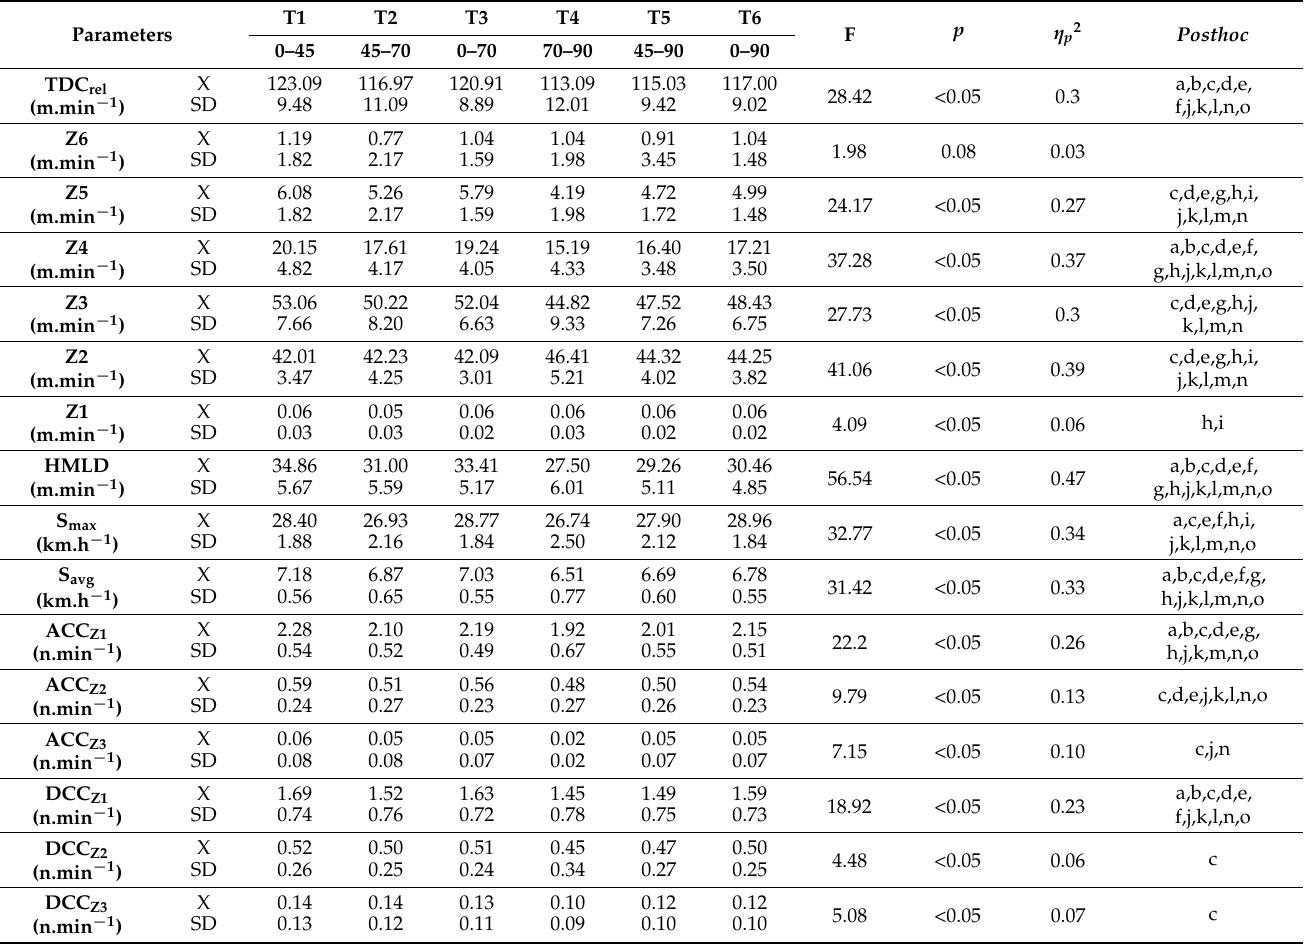
Table 1. Comparison of external load parameters of the different match time